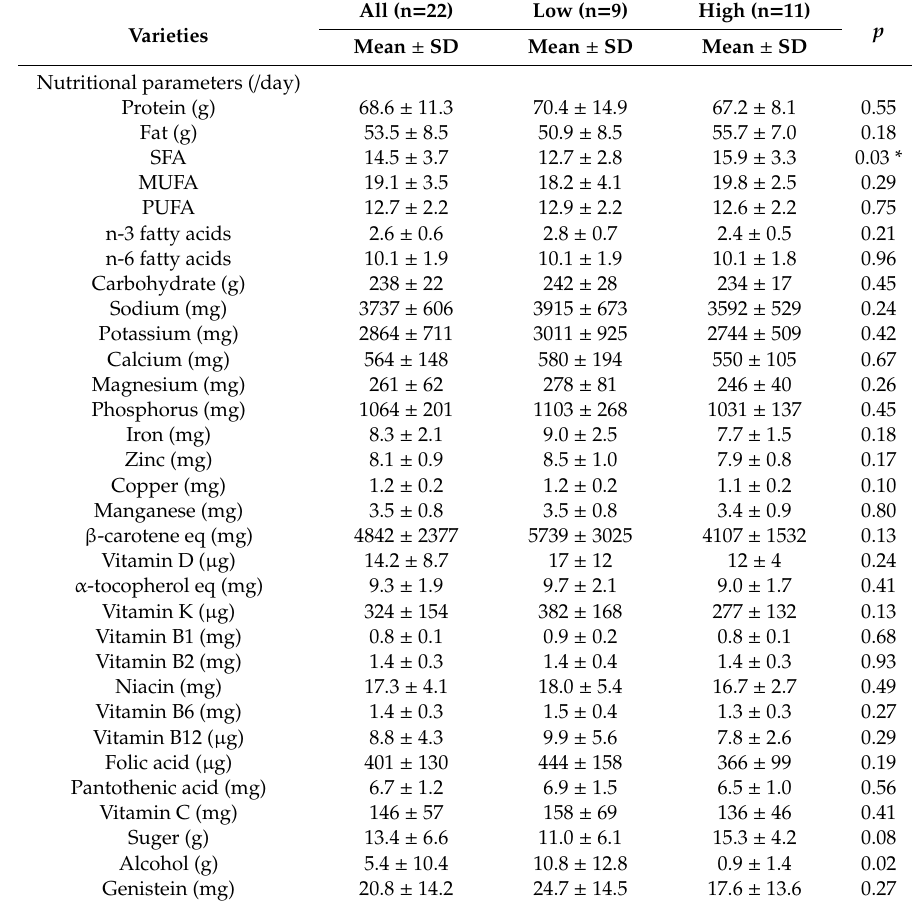
Table 3. Nutritional parameters for the whole study group and Low- and High-PWV groups